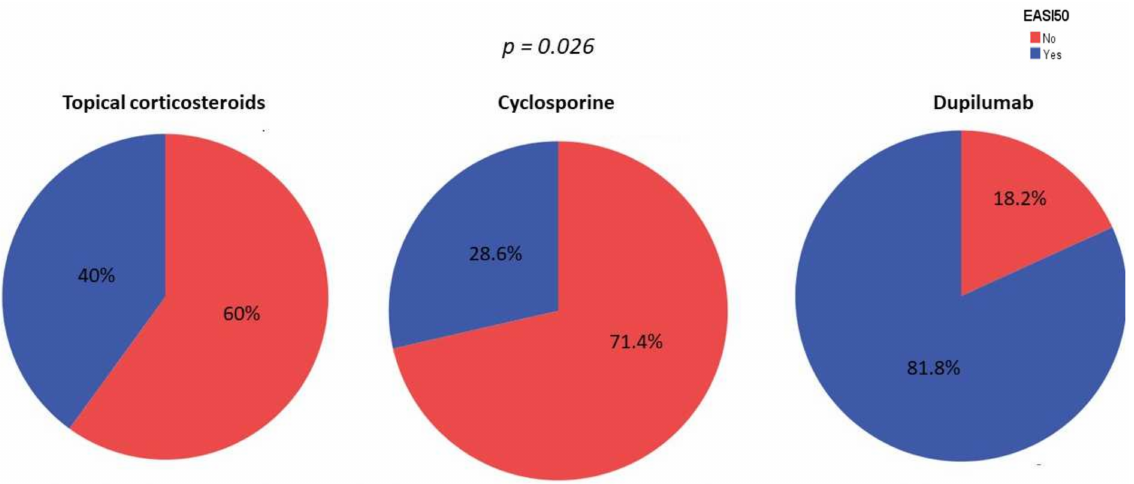
Figure 1. Percentage of patients achieving EASI-50 by treatment. p -value after conducting a multi- variate logistic regression model adjusted by age, age of disease onset, sex, smoking habit and skin hydration habit.